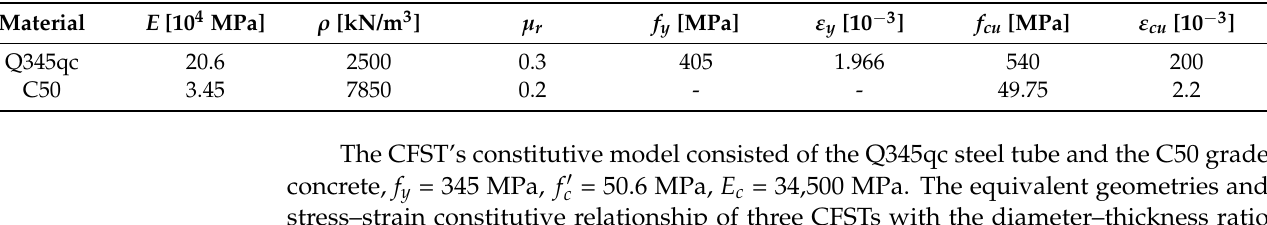
Table 5. Materials properties [51].